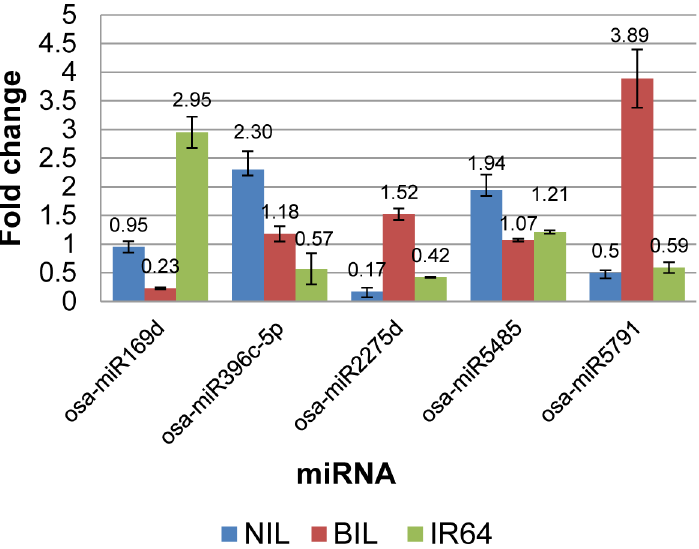
Fig 6. Fold change of quantitative stem-loop RT-PCR for shortlisted miRNAs. The heightof bar represents mean of normalizedfold change in triplicatesand its corresponding standard deviationis represented by error bar. NIL = IR87705-7-15-B and BIL = IR77298-14-1-2-10.